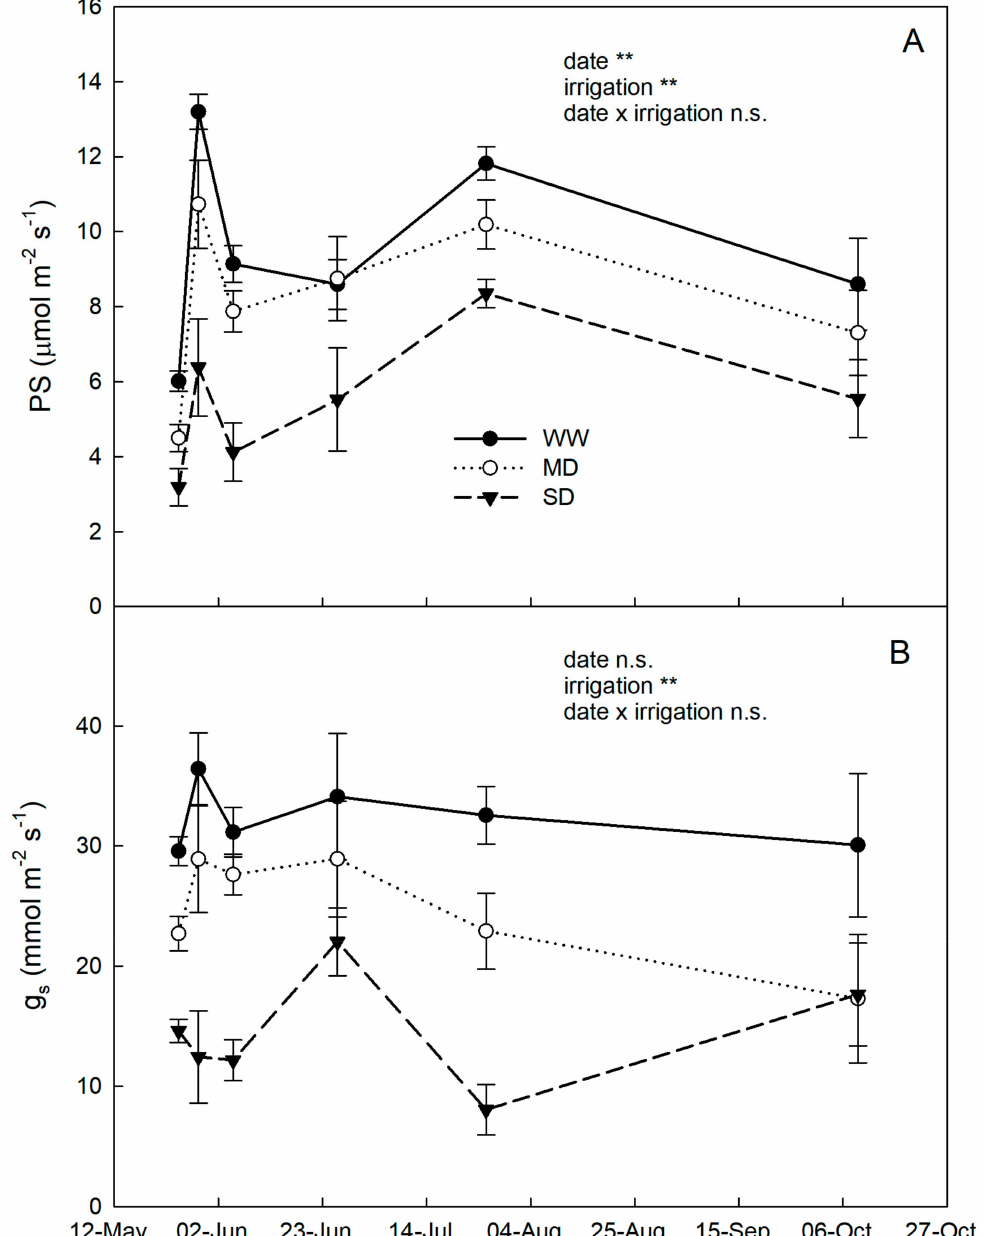
Figure 3. Photosynthetic rates (PS) ( A ) and stomatal conductance (g s, ) ( B ) in loquat plants under well-watered conditions (WW), mild drought (MD) and severe drought (SD) during the four months of drought. Significance level from analysis of variance: n.s., non-significant; **, significant at p < 0.001. Error bars represent standard errors of